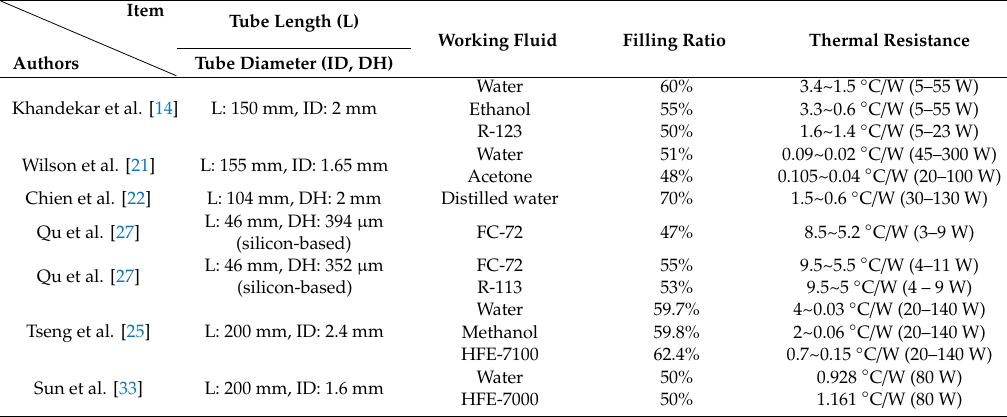
Figure 7. Resistance of the PHPs charged with water and HFE-7000 in the filling ratio of 35% and 50% at various evaporator temperatures at airflow velocity of 0.5 m/s. Table 3. PHP thermal resistance extracted from selected literature with vertical bottom heat mode.